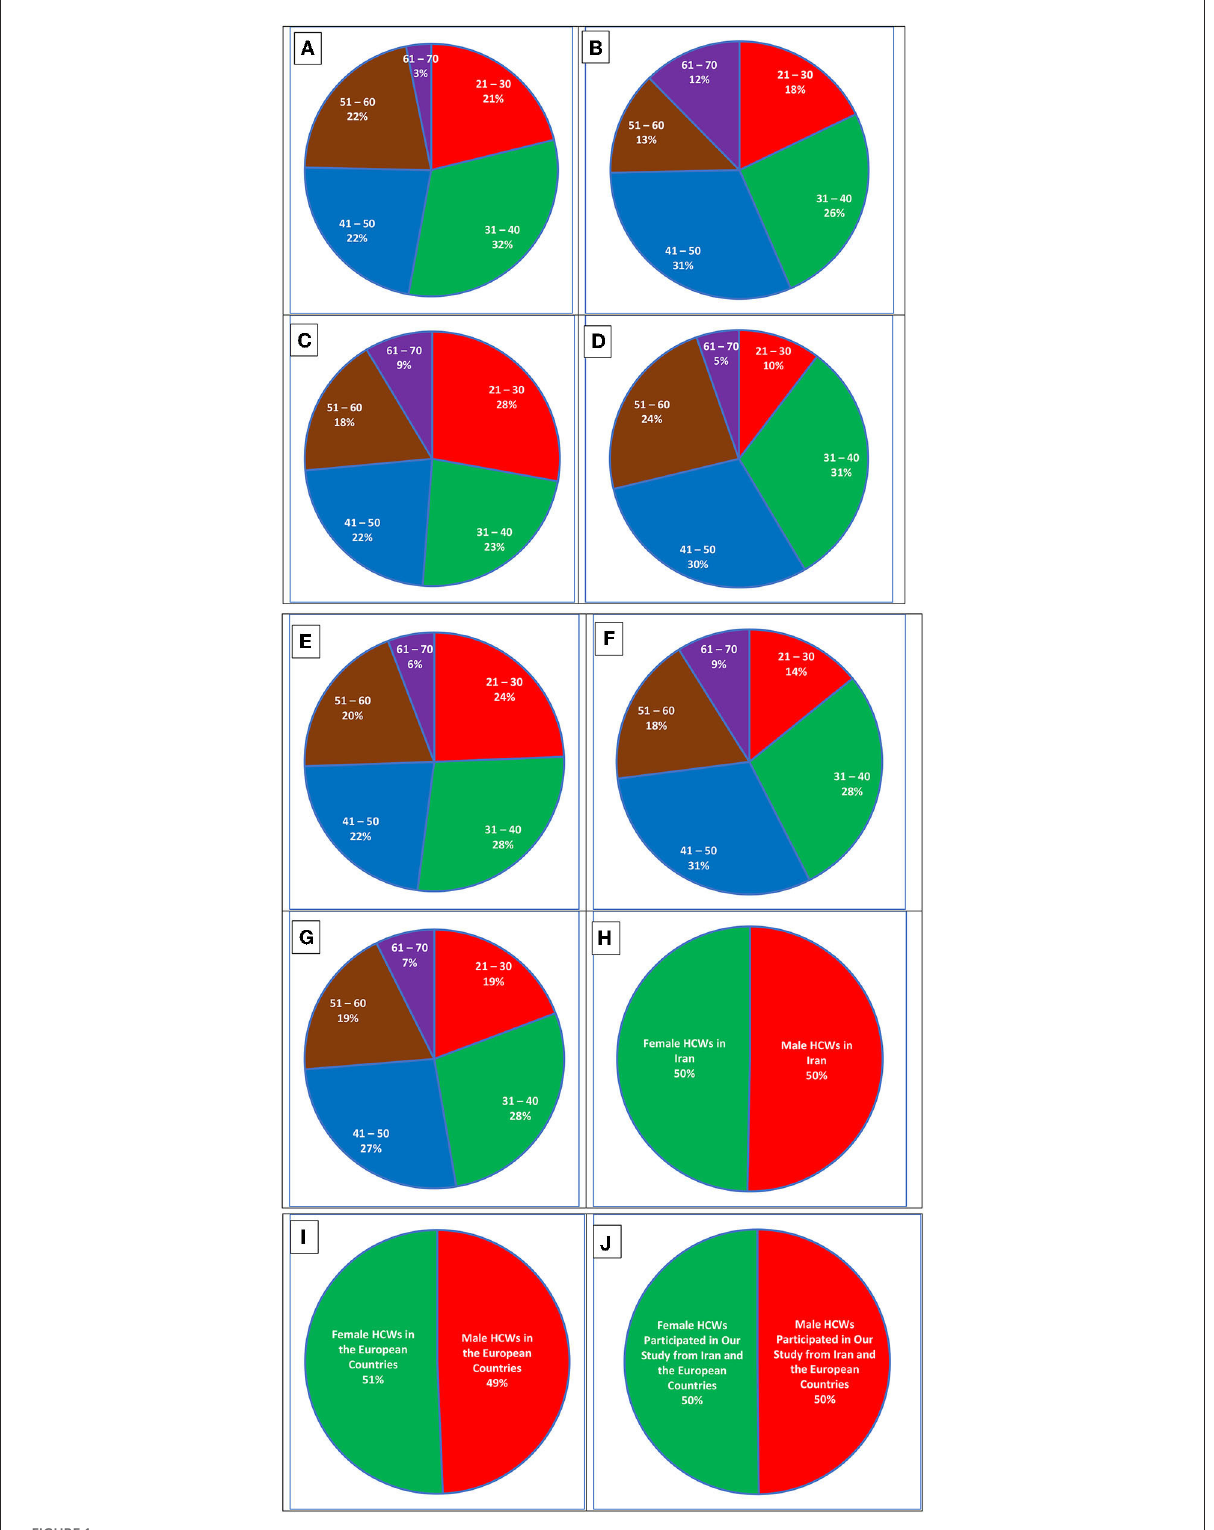
FIGURE1 Pie charts representing more details about the participants. (A) Male HCWs from Iran in our previously considered age groups. (B) Female HCWs from Iran in age groups. (C) Male HCWs from the studied European countries. (D) Female HCWs from the European countries. (E) The total number of male HCWs in Iran and the European countries. (F) The total number of female HCWs in Iran and the European countries. (G) Sum of all HCWs who participated in this study from Iran and the European countries. (H) The number of male participants vs. the number of female participants in Iran. (I) The number of male participants vs. the number of female participants in the European countries. (J) The total number of all male participants vs. the total number of all female participants in Iran and the European